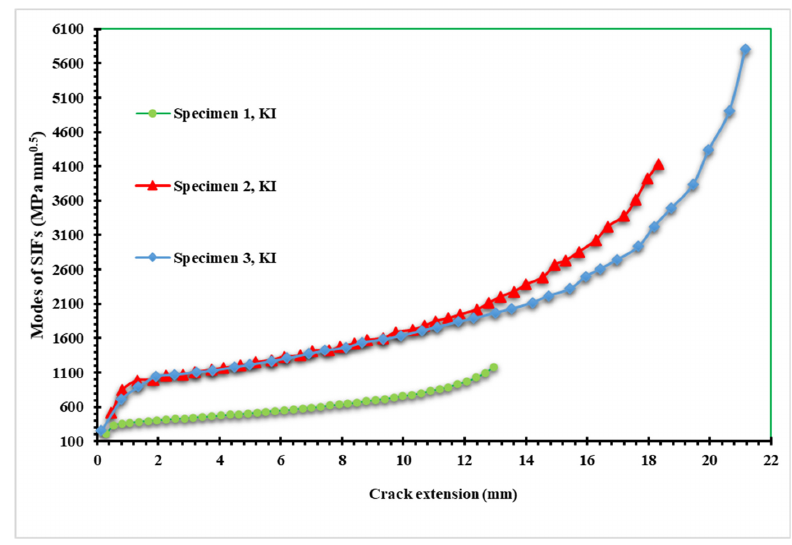
Figure 9. The first mode of SIFs versus crack length for the three specimens.